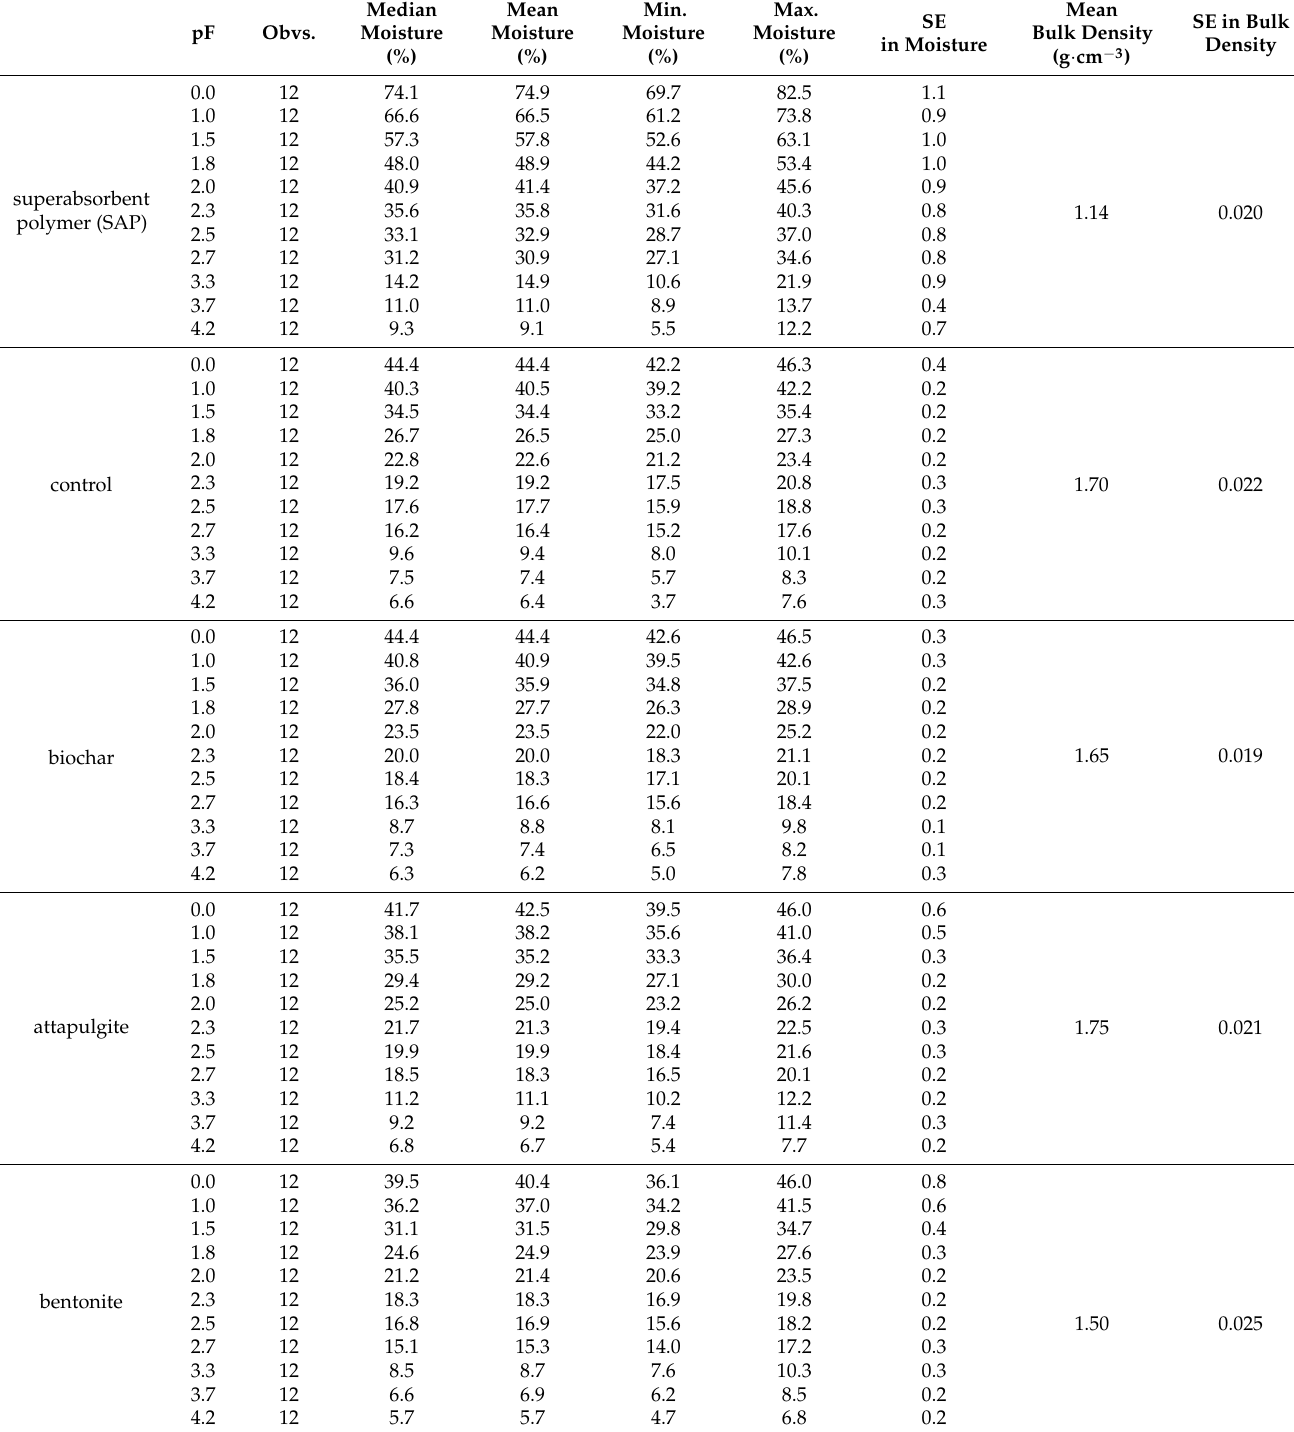
Table 5. Descriptive statistics of data acquired as a result of the pressure plate extractor